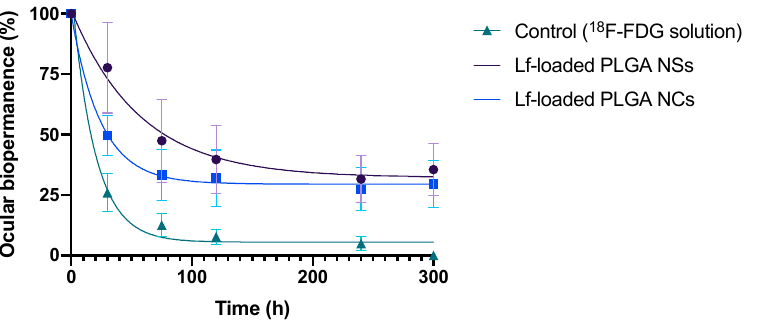
Figure 17. Ocular biopermanence of a 18 F-Choline radiolabeled PLGA-based nanoparticles and a 18 F-FDG aqueous solution (control), assessed pondering the primary biopermanence data (%) in the ROI. Statistically significant differences ( p < 0.05) were observed regarding PLGA-based formulations and 18F-FDG solution.